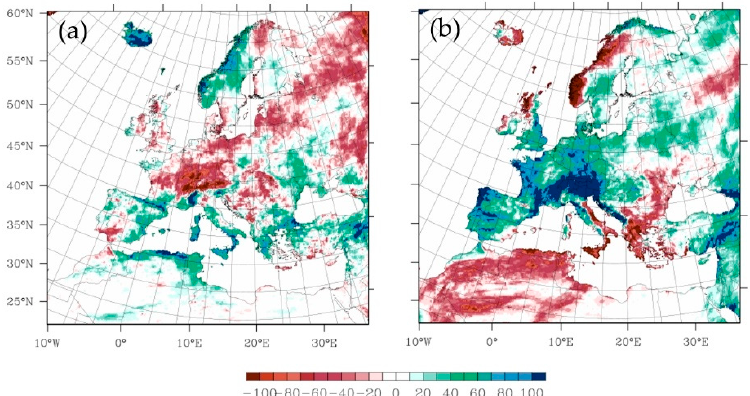
Figure 5. Current (years 1970–2000) ( a ) and projected (years 2070–2100) ( b ) thermal time (in growth degree days, GDD) under the RCP8.5 scenario in Europe. The base temperature is set at 10 ◦ C which applies to the requirements of C4-crops such as miscanthus ( Miscanthus × giganteus Greef et Deuter) and maize ( Zea mays L.).